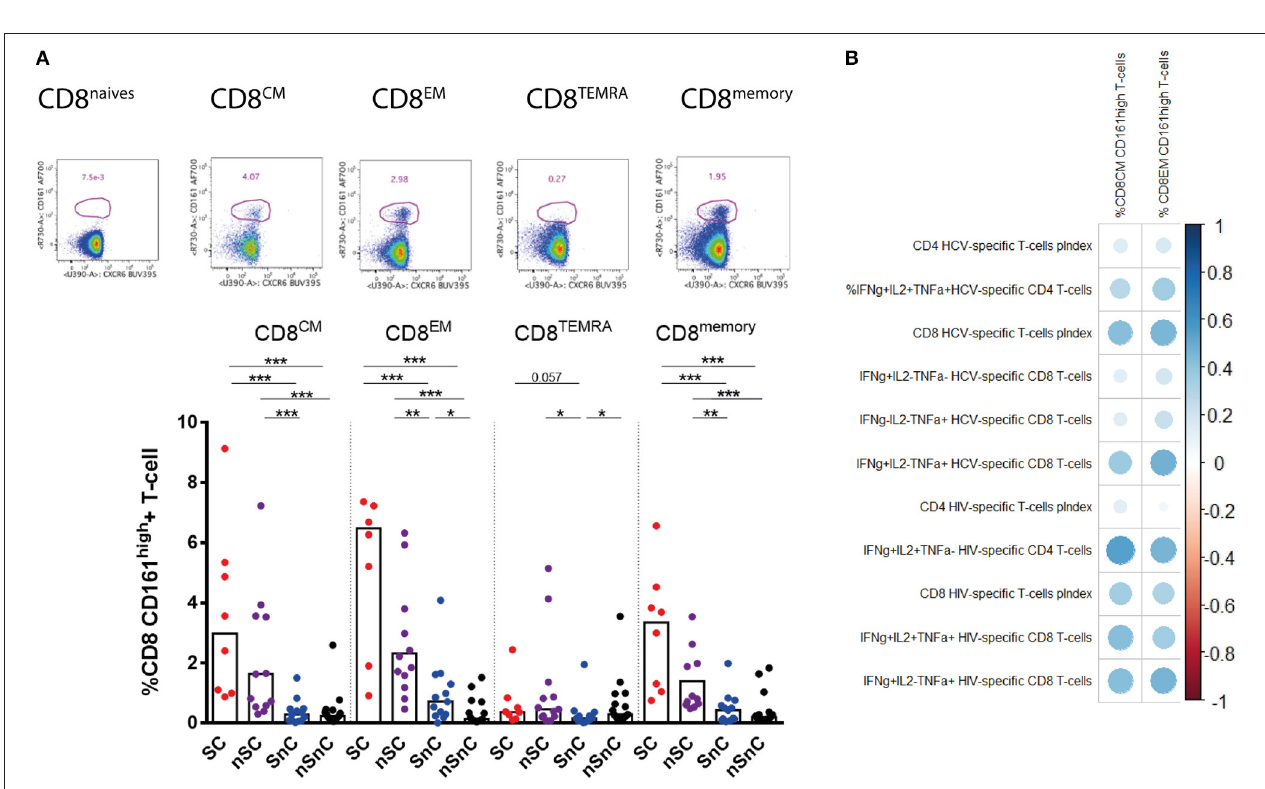
FIGURE 5 | CD161 high CD8 T-cells. (A) Frecuency of CD161 high among CD8 T-cells subsets. Mann–Whitney U -tests was used to assess diferencies between groups. (B) Pearson correlation between CD161 high CD8 T-cells and HCV- and HIV-specific T-cell responses. SC, supercontrollers, HCV spontaneous clearers and HIV-elite controllers; nSC, non-spontaneously HCV clearers HIV-elite controllers; SnC, HCV spontaneous clearers non-HIV-elite controllers; nSnC, non-spontaneously HCV clearers non-HIV-elite controllers. Statistical values are shown as: * p = 0.05–0.01; ** p = 0.01–0.001; *** p < 0.001. The ball size correspond with the magnitude of Pearson’s r -value.